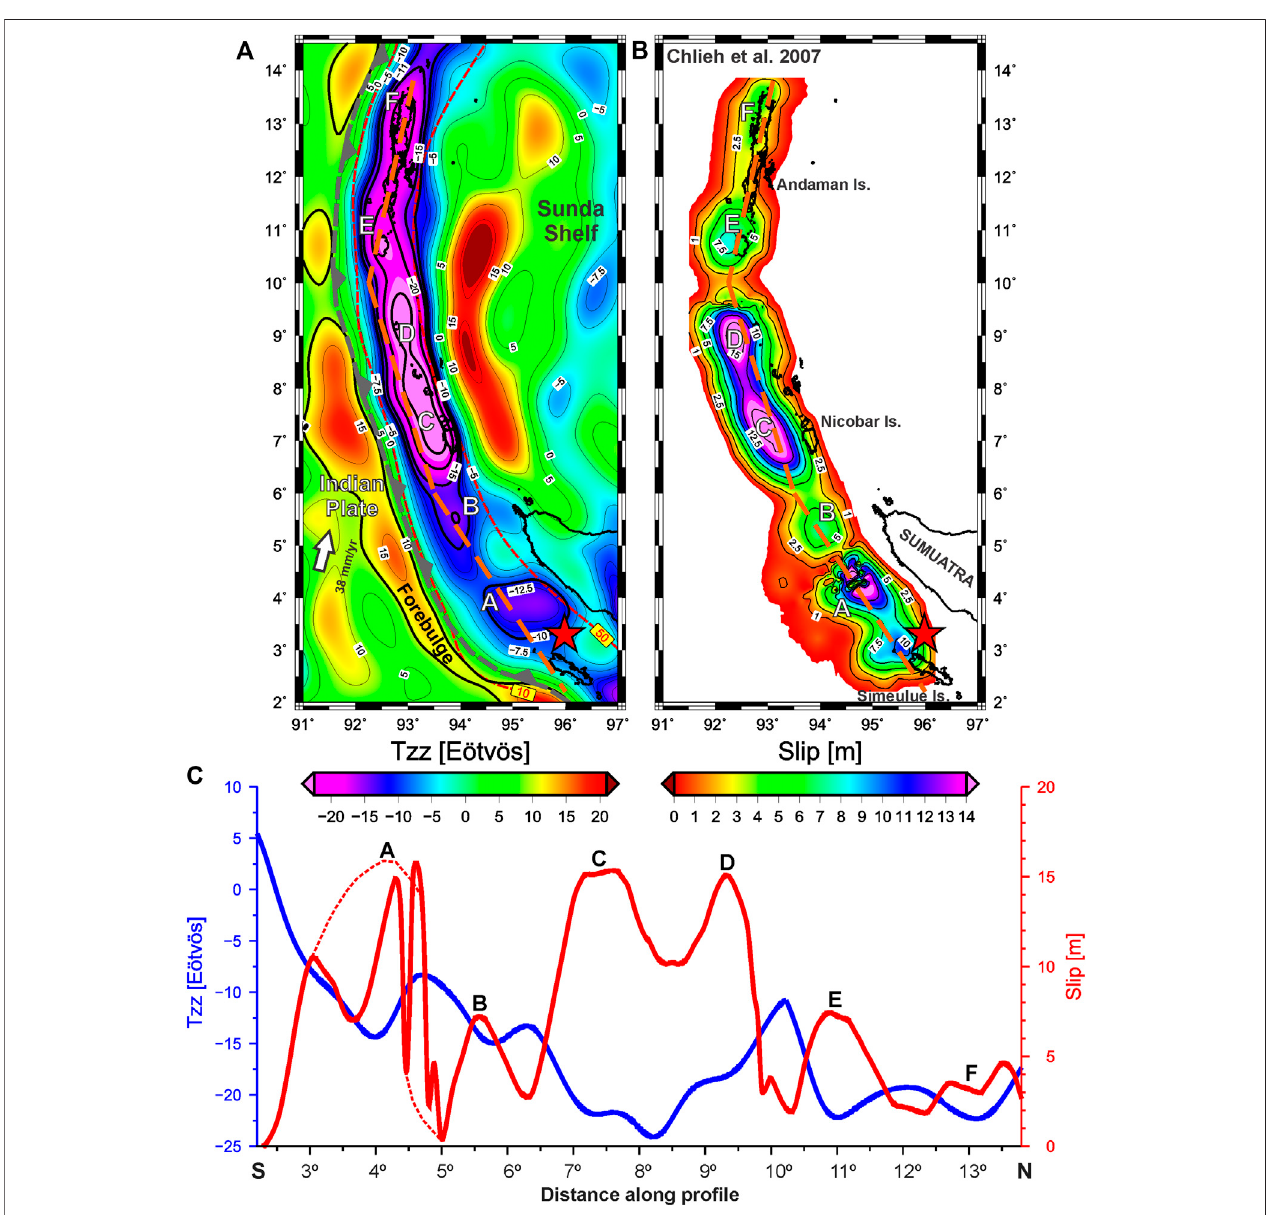
FIGURE4|(A) Topographycorrectedverticalgravitygradient(Tzz)obtainedfromGOCEmodelGO_CONS_GCF_2_DIR_R6uptoN (cid:1) 200(Bruinsmaetal.,2014). Slabdepthsof10 kmand50 kmfrom Slab2.0ofHayes (2018) areplottedwithred dashed lines. (B) Slipmodel fortheMw (cid:1) 9.152004Sumatra-Andamanearthquake (Chlieh et al., 2007). (C) Latitudinal pro fi le alongthe Tzz signal (blue) and along the slip model (red), letters indicate the location ofasperities where slip is enhanced. Note that maximum slipcoincideswithminimumTzzand viceversa. Thered dashed lineindicates a “ high-wavelength ” component oftheslip.Letters AtoFindicate the location of different seismic asperities where a high amount of energy and minor short-period seismic radiation were released.